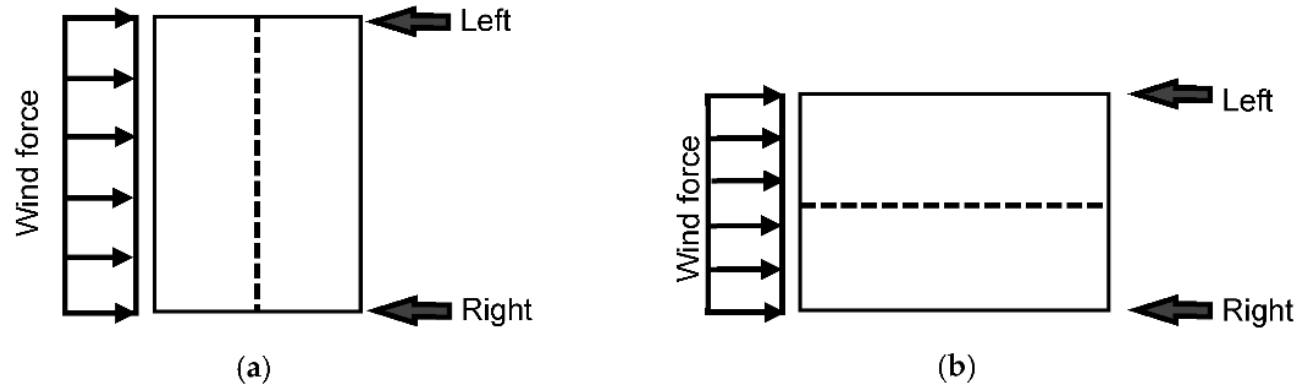
Figure 4. Convention to define the base shear force: ( a ) wind normal to ridge, and ( b ) wind parallel to ridge.